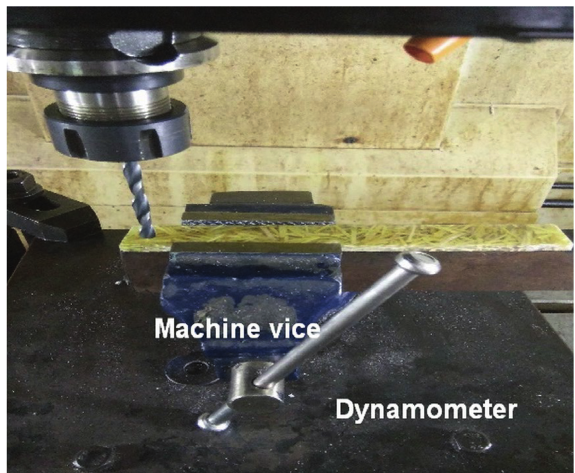
Figure 2: Drilling experimental setup.